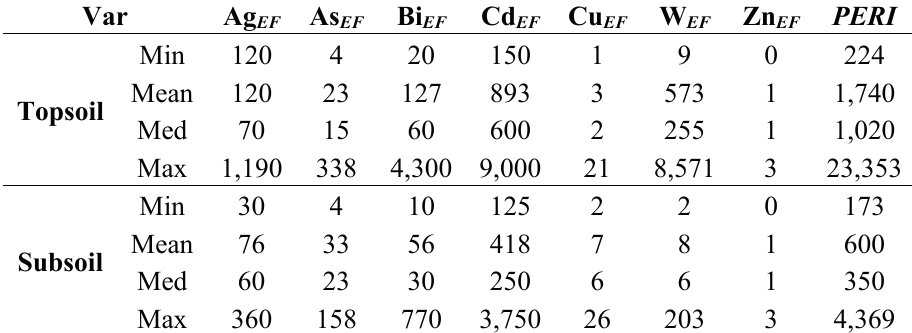
Table 9. Statistical results of the single element potential pollution factor ( EF ) and potential ecological risk ( PERI ) for topsoil and subsoil samples.